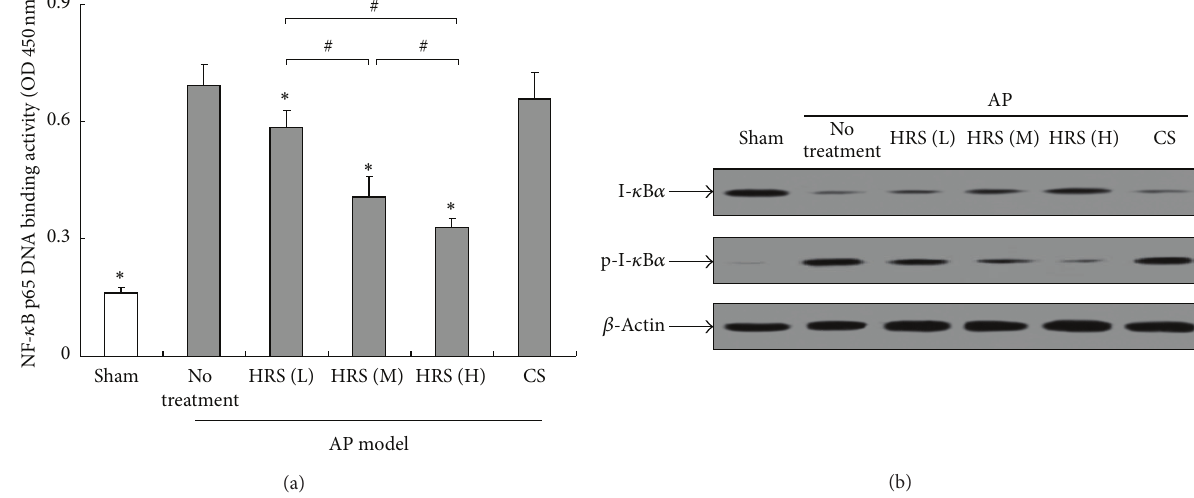
Figure 2: Evaluation of pancreatic NF- 𝜅 B activation in mice. The HRS at various doses or control saline (CS) was injected intraperitoneally to AP mice 1h after the final injection of cerulein, respectively. The pancreatic tissue samples were collected from sacrificed animals in each group ( 𝑛 = 6 ) 24h after the initiation of AP and then homogenized on ice. After the measurement of protein concentration, NF- 𝜅 B activation was evaluated by measuring the DNA-binding activity of NF- 𝜅 B p65 in nuclear extracts using an ELISA kit (a) and by detecting the protein levels of I- 𝜅 B 𝛼 and p-I- 𝜅 B 𝛼 in pancreatic homogenates (b). L: low dose (2 mL/kg × 3); M: middle dose (4mL/kg × 3); H: high dose (8mL/kg × 3).